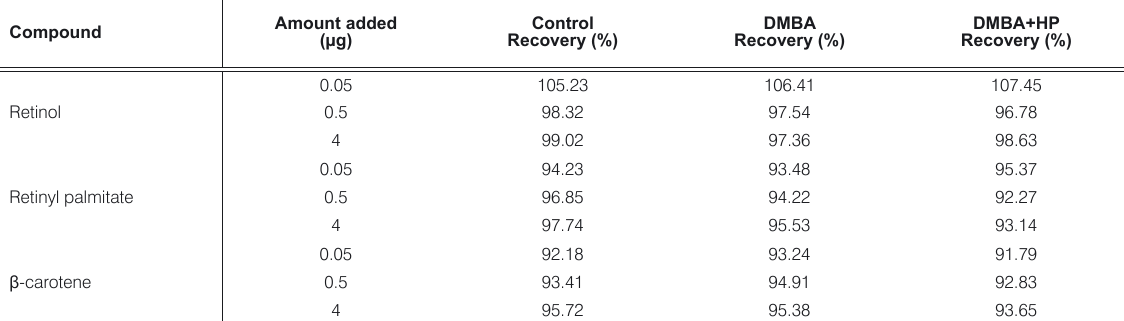
Table 4. Recovery of analysis of Retinol, Retinyl palmitate and β -Carotene in the serum extracted